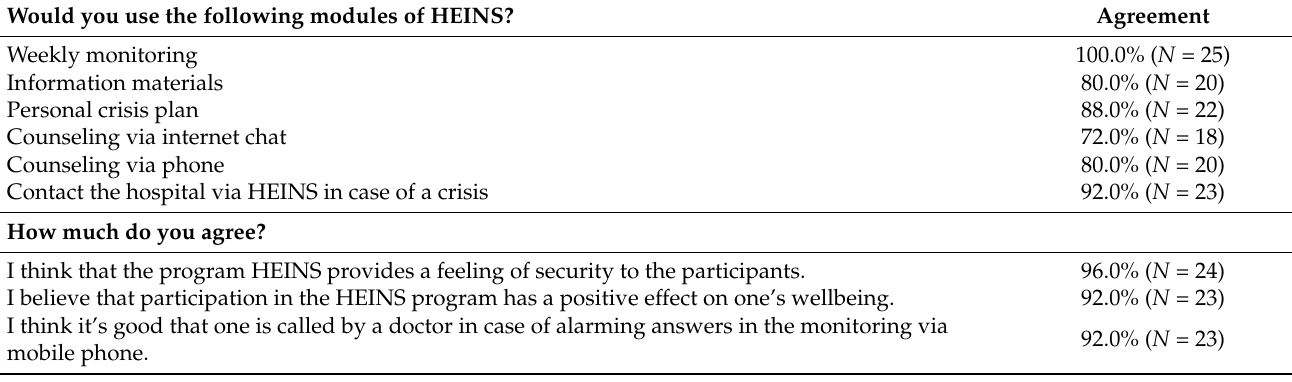
Table 2. Attitudes and